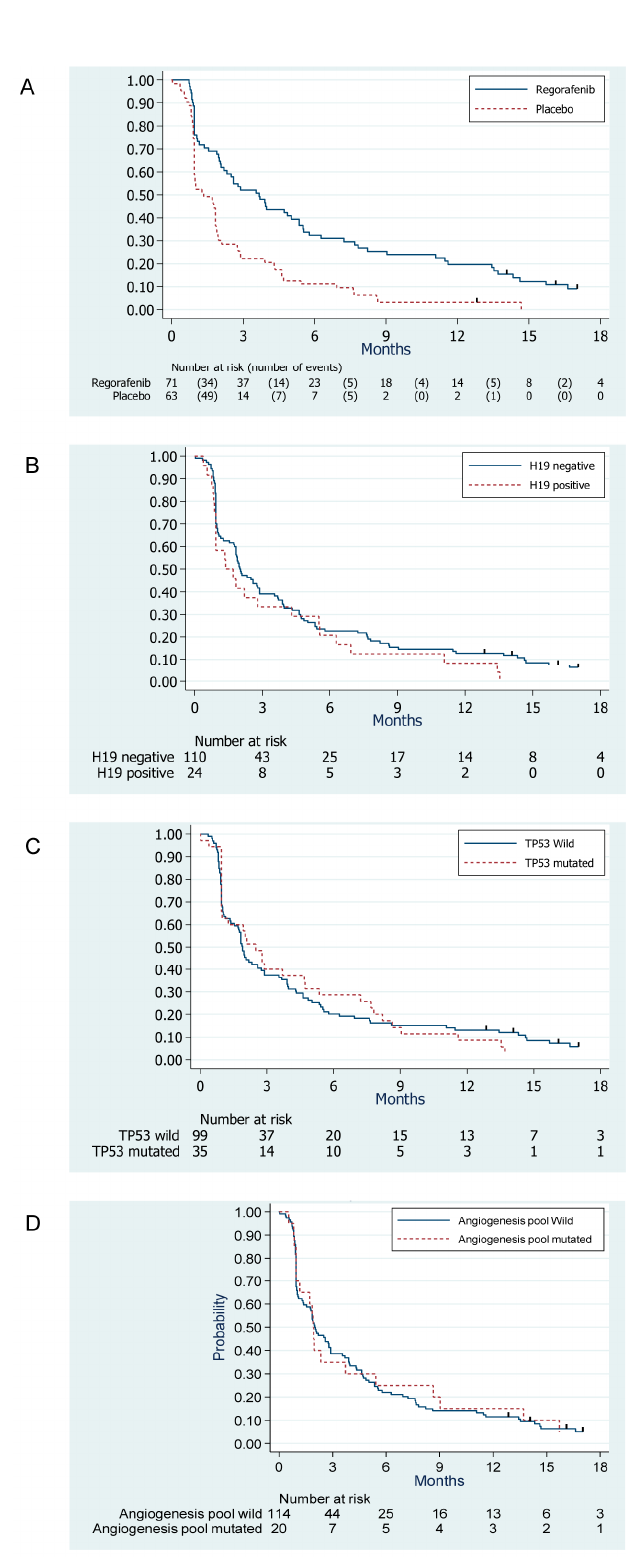
Figure 1. Kaplan-Meier estimates of progression-free survival curves according to treatment arm ( A ), H19 status ( B ), TP53 mutation ( C ), and presence of mutation in the angiogenesis pool ( D ).